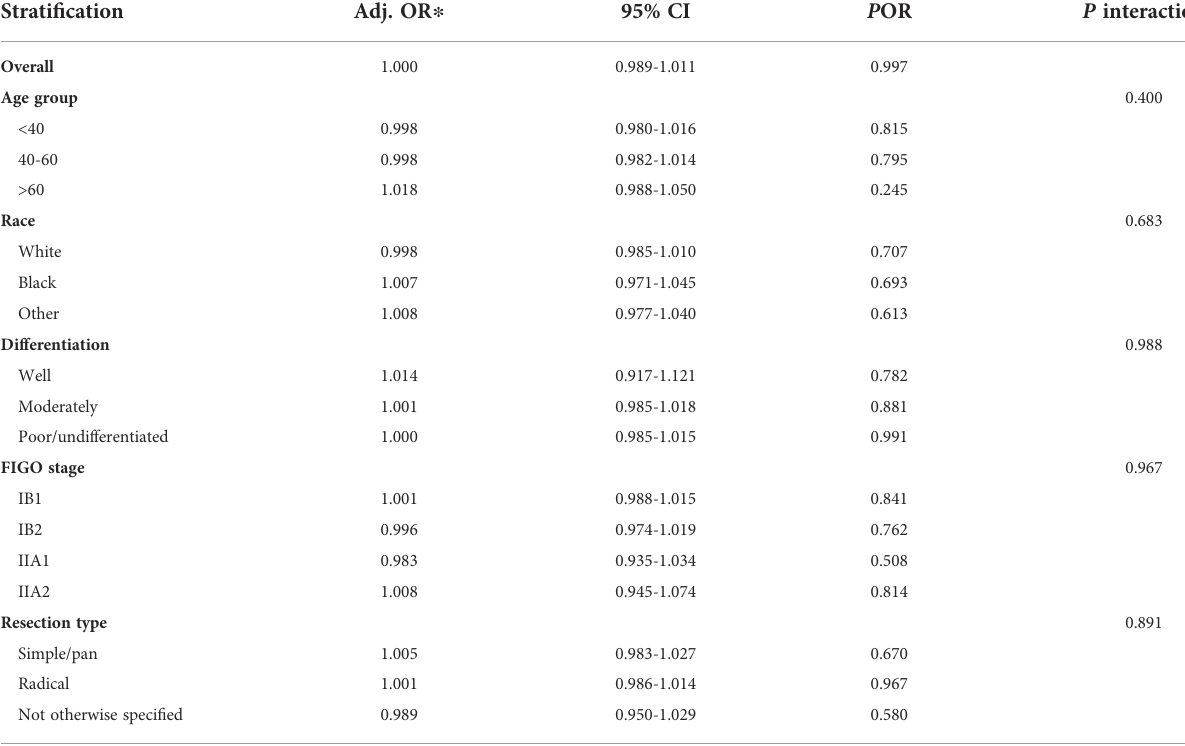
TABLE 2 Association of examined lymph node number (as a continuous variable) with negative-to-positive node stage migration. Strati fi cation Adj. OR